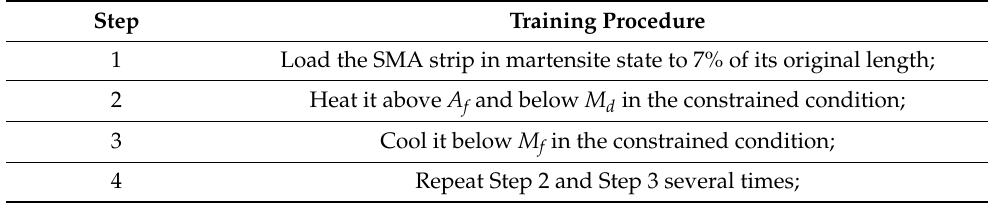
Table 2. TWSME thermomechanical cycling training method.